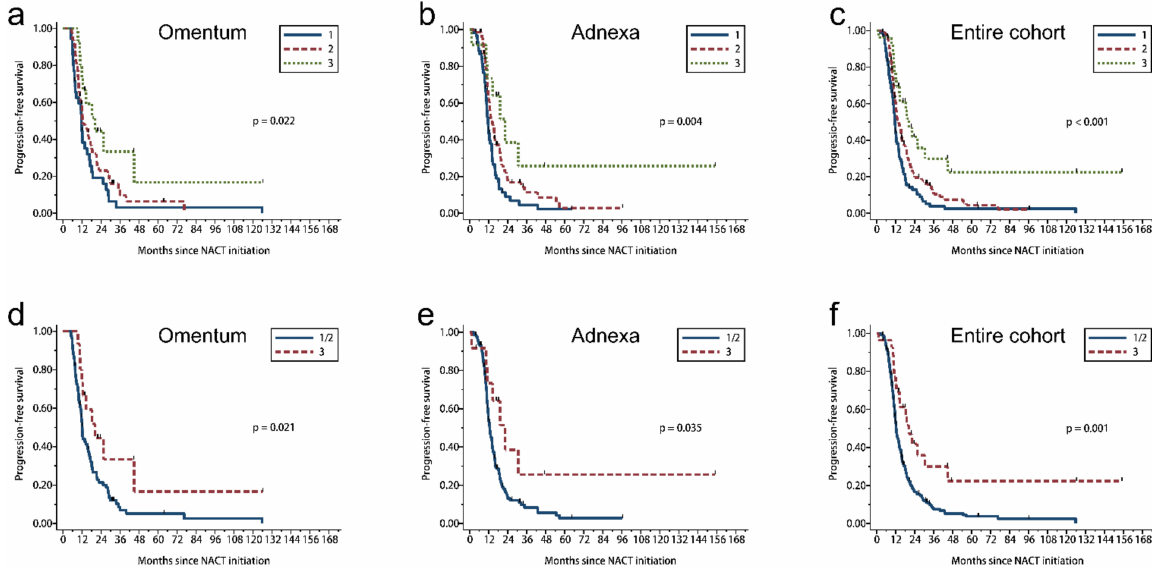
Figure 7. Kaplan–Meier estimates of PFS according to CRS for the entire cohort and scoring site subgroups. ( a – c ) Three-tier CRS. ( d – f ) Modified 2 tier CRS (CRS 1 and 2 versus CRS